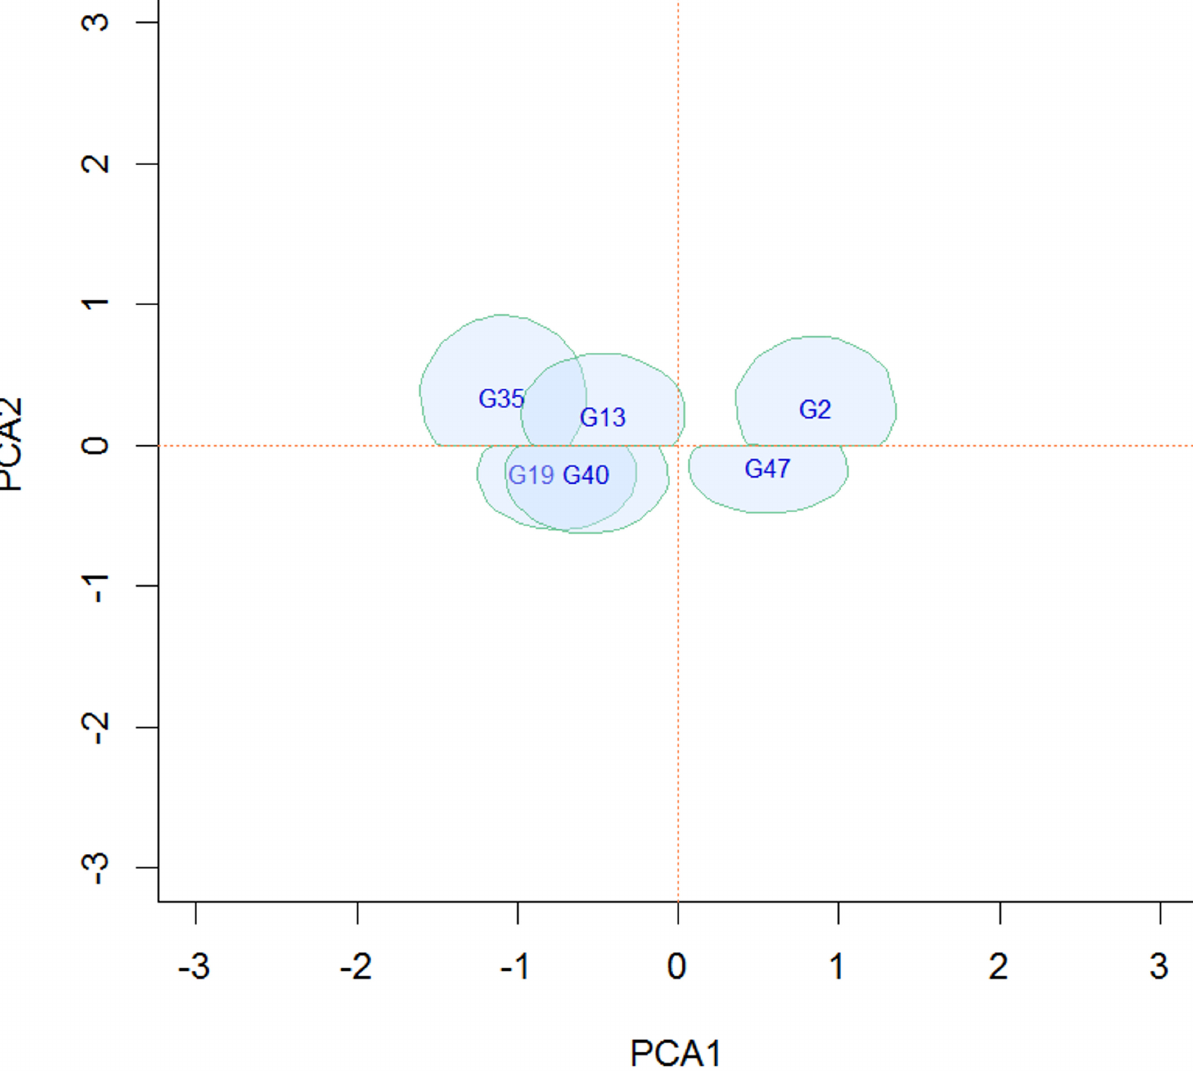
Fig 11. 95% credible regions that do not include the origin for the first two principal axes of the genotype scores using the AMMIBS